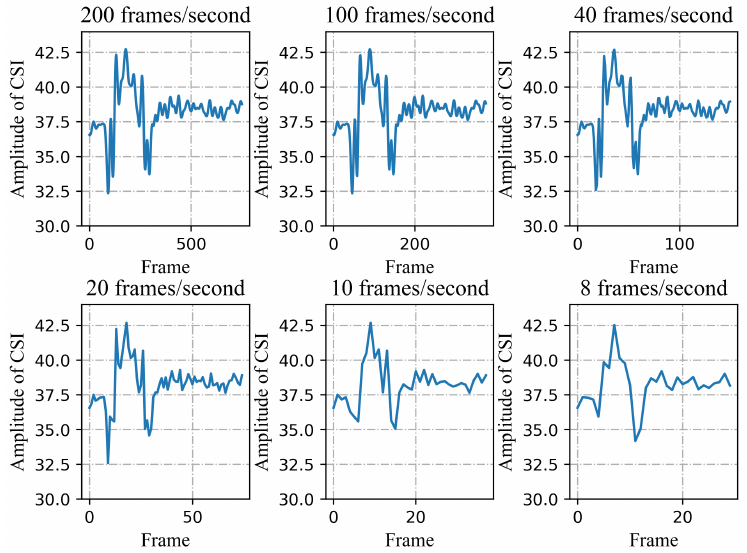
Figure 8. Amplitude of subcarrier of nine TX-RX antenna pairs.